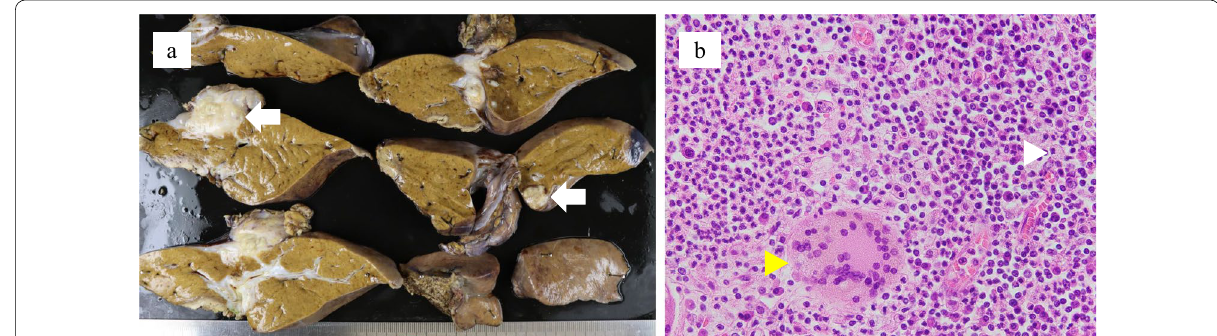
Fig. 6 Histopathological examination of the resected specimens. a Gross findings showed the falciform ligament mass and the yellowish-white nodule in liver segment three (white arrows). b Microscopic examination revealed numerous neutrophils, giant cells (yellow arrowhead), and foam cells (white